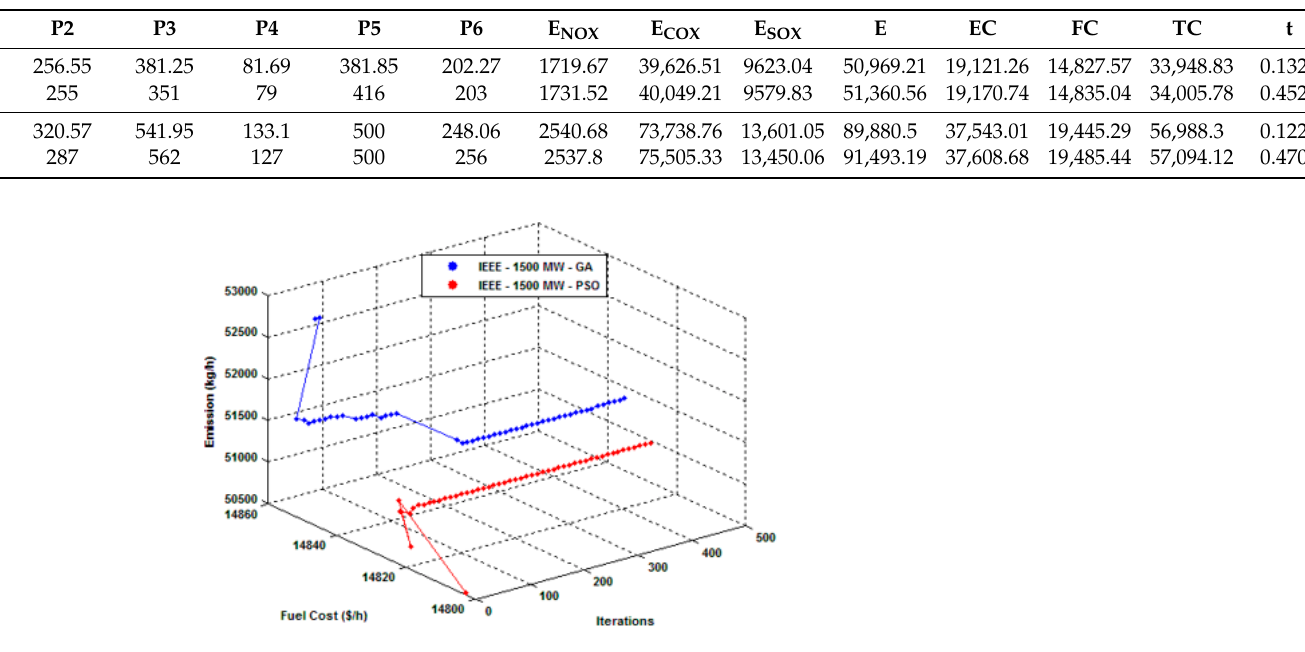
Figure 4. The convergence characteristics of PSO and GA with regard to fuel cost and emission for IEEE 30 bus system with P D = 1500 MW.